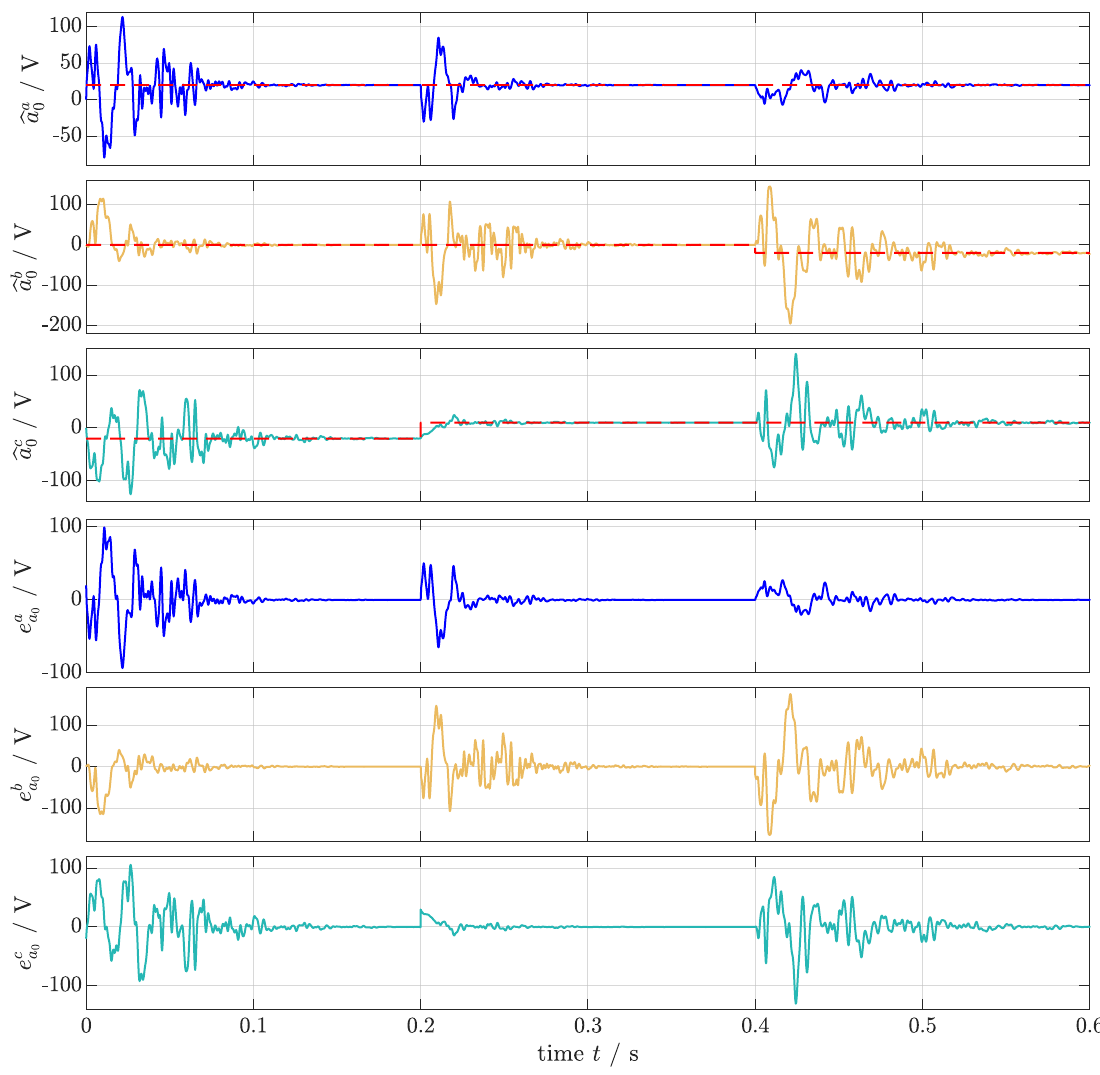
a b a c 0 , 0 & 0 ( ), its estimates (cid:98)